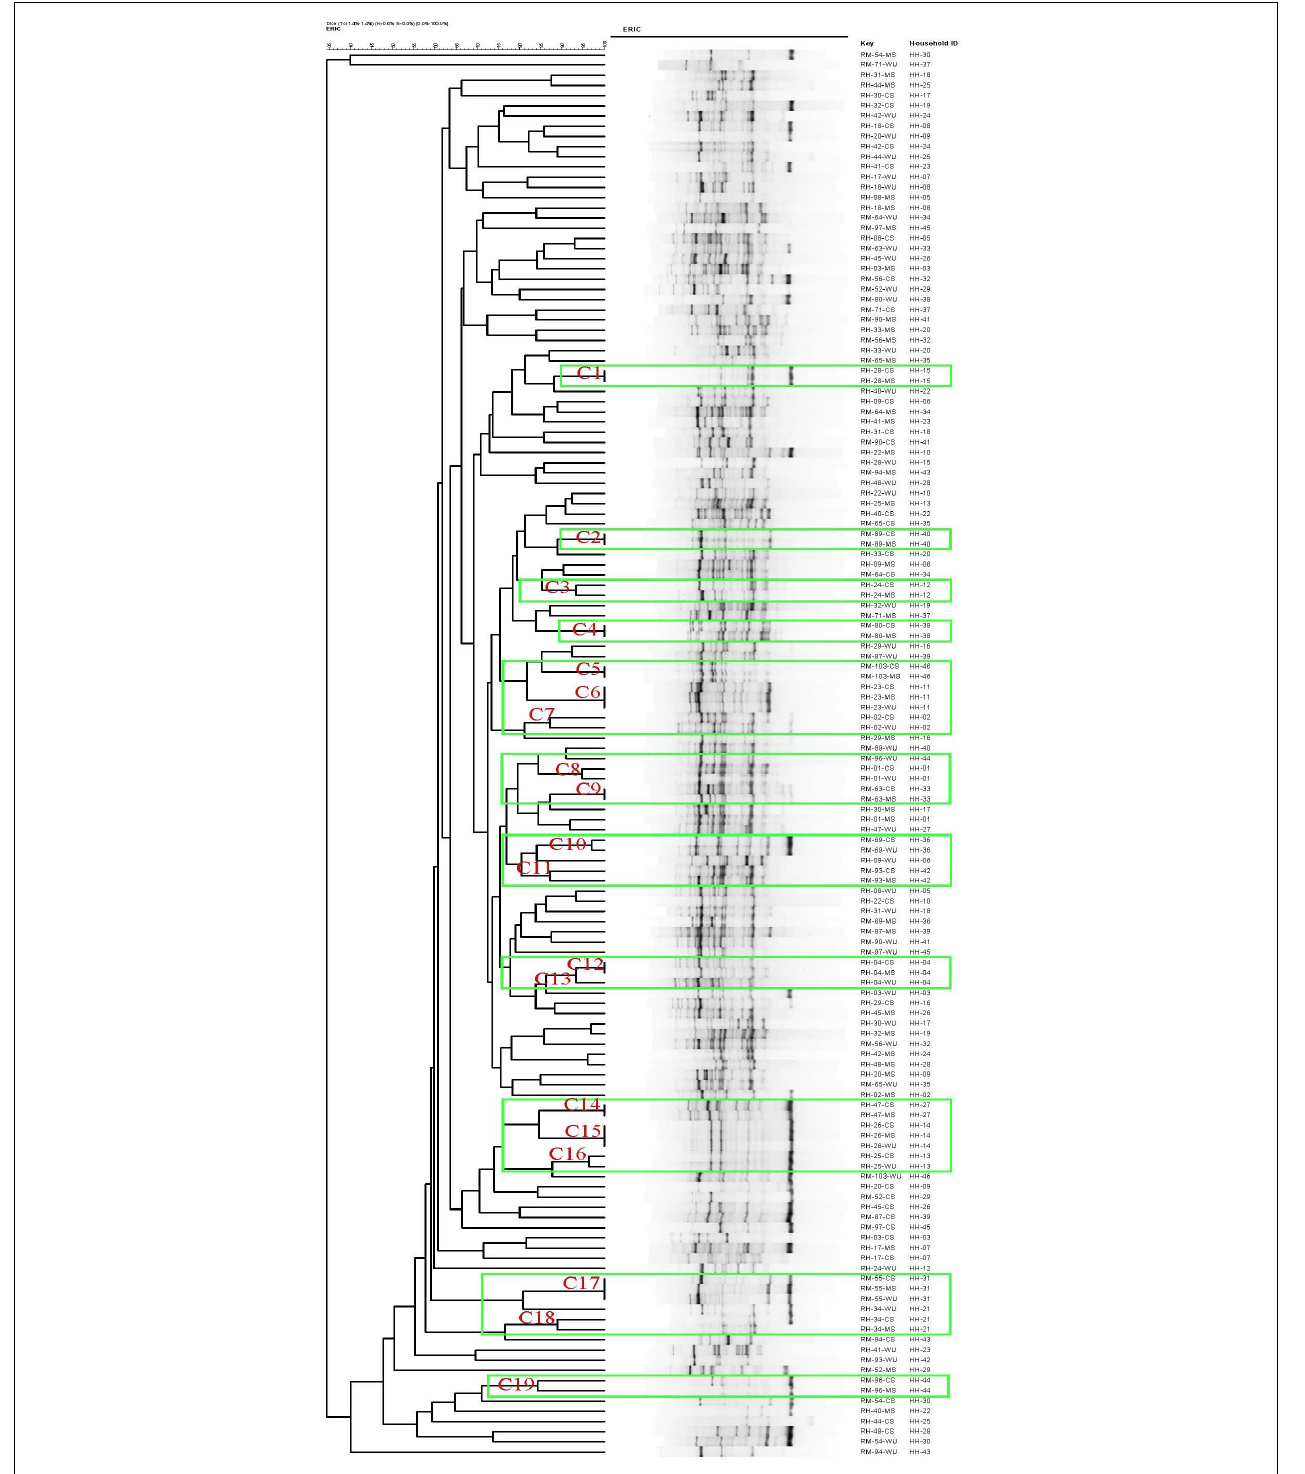
FIGURE 2 | Dendrogram generated by BioNumerics software, showing distances calculated by Dice similarity index of enterobacterial repetitive intergenic consensus polymerase chain reaction banding patterns of E. coli strains obtained from stool samples of mother and child and point-of-use drinking water samples from 46 households. Degree of similarity (%) is shown on